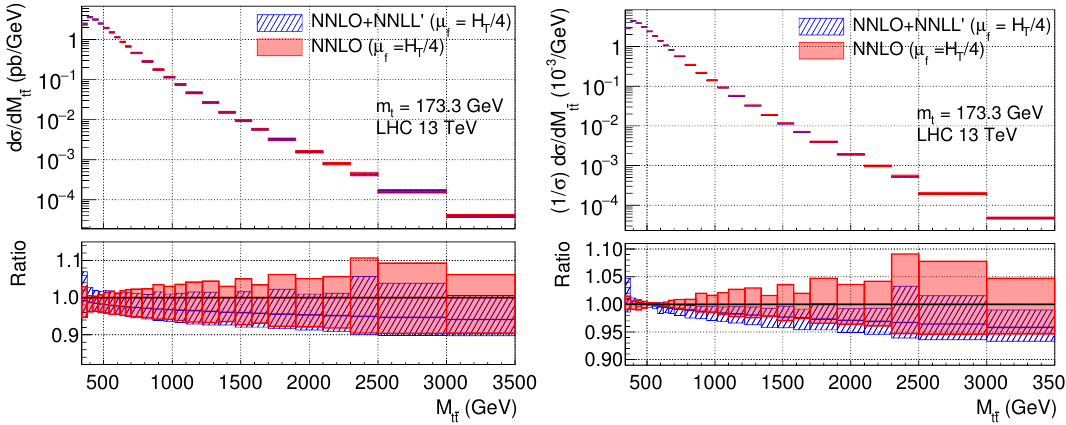
Figure 4 . Results for the absolute (left) and normalized (right) top-pair invariant mass distribution at the LHC with p s = 13 TeV. In all cases the ratio is to the NNLO result with (cid:22) f = H T = 4. The uncertainty bands are obtained through scale variations as described at the beginning of section 5 and in eqs. (5.1) and